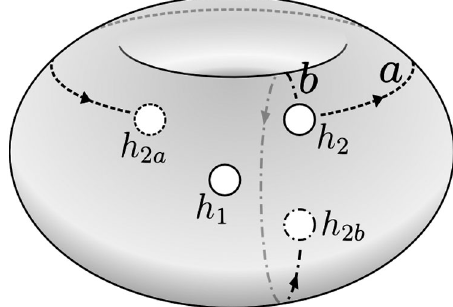
FIG. 6. Different configurations (cid:10) can be connected by drag- ging one quasihole along a global path. Initially, the two quasi- and h are in configuration (cid:10) ¼ þ . Keeping the holes at h 1 2 fixed, the quasihole at h can be moved along one quasihole at h 1 2 moves around of two paths: path a , in which the quasihole at h 2 , or path b , in which the the torus in the x direction to h 2 a moves around the torus in the y direction to quasihole at h 2 h . Both paths can be used to change the configuration (cid:10) while 2 b keeping quasiholes well separated in both x and y . At the same time, the topological sector also